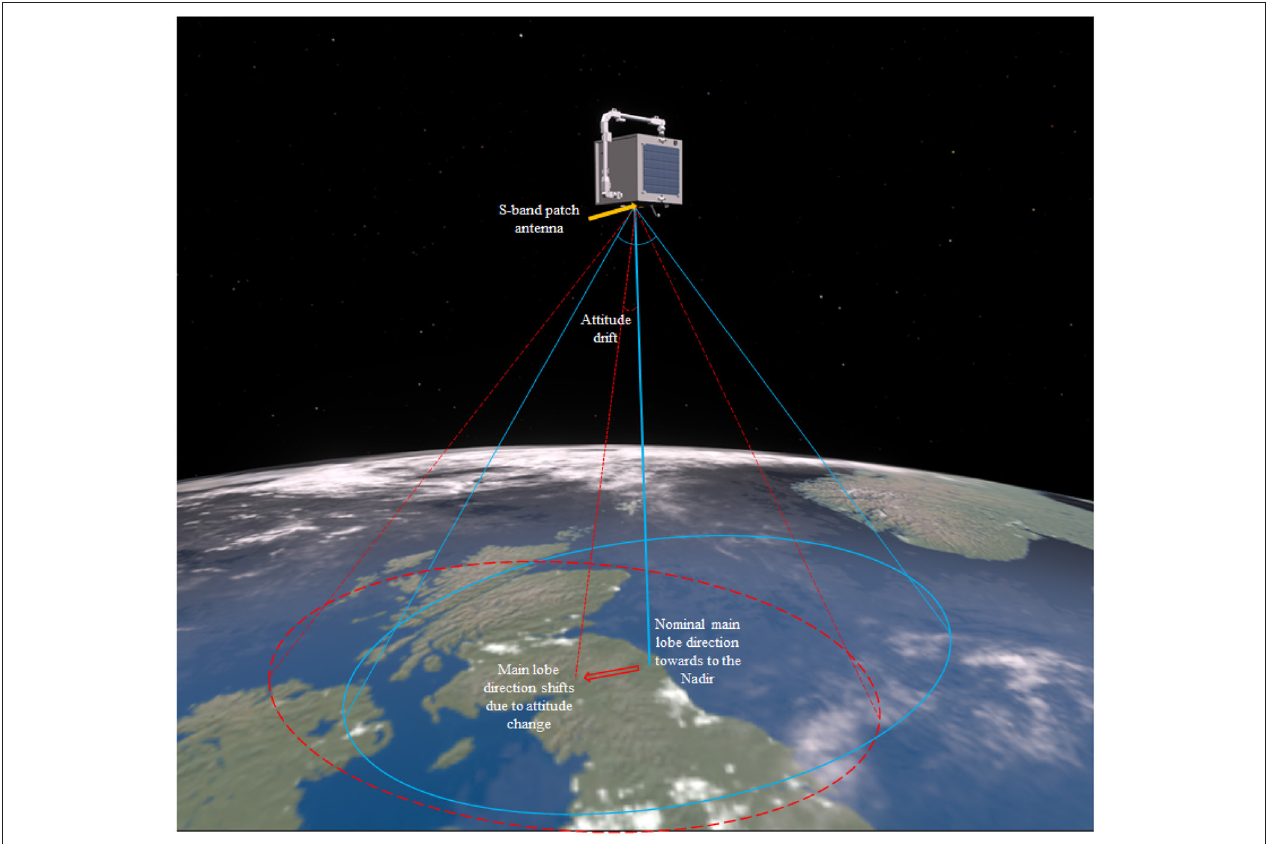
FIGURE 11 | The attitude requirement for proposed free-floating spacecraft is to minimize the angular drift within the half-power beamwidth (HPBW) during manipulation period to maintain stable